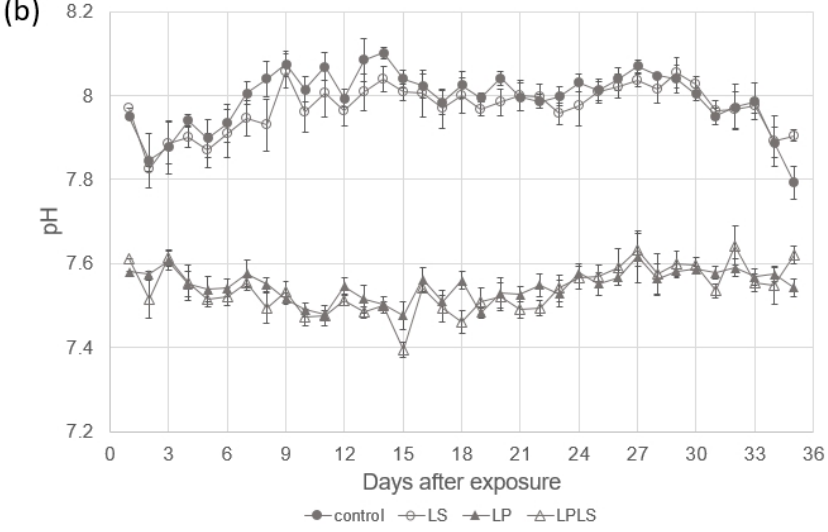
Figure 2. Salinity ( a ) and pH ( b ) data during this experiment in response to targeted exposure (Mean ± SE). The pH was measured every day and night and the salinity was measured when the experimental seawater was replaced.